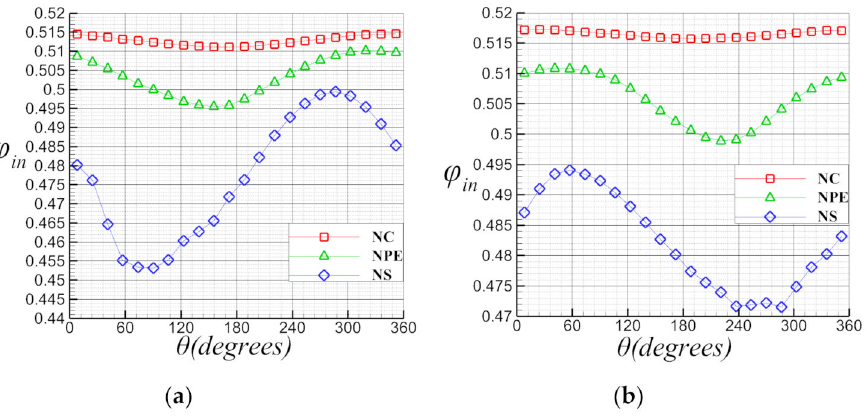
Figure 16. Distribution of inlet flow coe ffi cient along the circumference in the case of 160% eccentricity. ( a ) Steady CFD result; ( b ) unsteady CFD result.